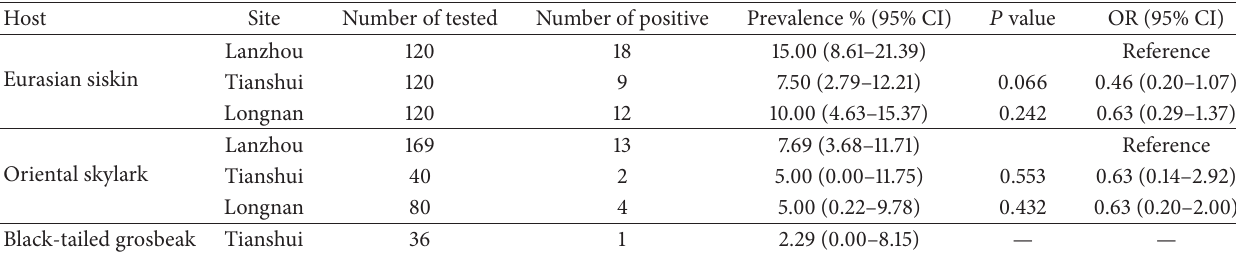
Table 1: Seroprevalence of HEV infection in pet birds in Gansu, northwest